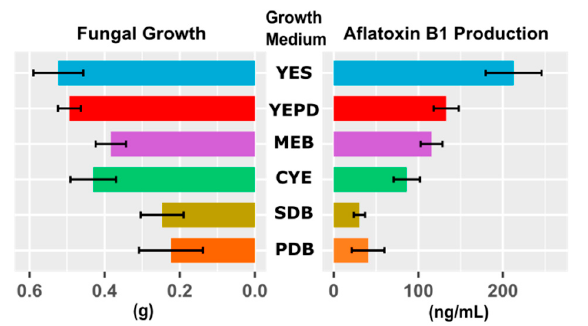
Figure 1. Selecting the optimal culture medium for A. flavus growth and aflatoxin B1 production. Mean and standard deviation (computed across repeated measurements) of A. flavus strain NRRL 3357 growth and aflatoxin B1 production in six culture mediums: Potato Dextrose Broth (PDB), Sabouraud Dextrose Broth (SDB), Czapek Yeast Extract (CYE), Malt Extract Broth (MEB), Yeast Extract Peptone Dextrose (YEPD), and Yeast Extract Sucrose (YES). Our analysis showed that, compared to other culture media, the Yeast Extract Sucrose (YES) medium provides a highly significant condition for fungal growth and aflatoxin B1 production.